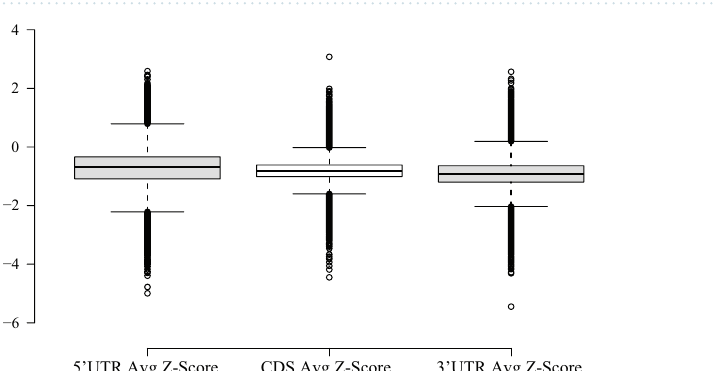
Figure 1. Violin plots of various average ScanFold metrics across the transcriptome. ( a ) The average windowed z-score that is shifted to a slightly negative overall value of −0.43 with outliers of −3.59 and +1.65. ( b ) The average windowed MFE (ΔG) that is centered around −31 kcal/mol with outliers of −66.68 kcal/mol and −3.68 kcal/mol. ( c ) The average number of motifs per transcript with z-score ≤ −2. The average was 3.92 and ranged from 0 to 181.